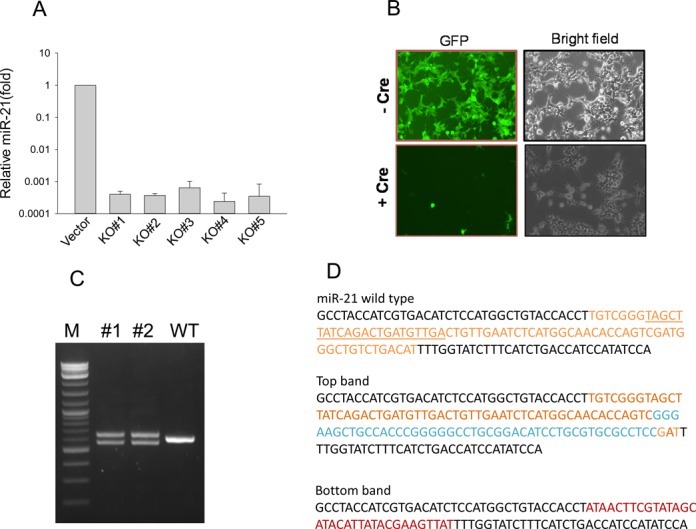
Identification of miR-21 KO clones and elimination of marker genes. (A) Detection of miR-21 level by qRT-PCR. Over a 1000-fold reduction was detected in all of the five miR-21 KO clones with P value <0.01 for all five clones. (B) Excision of marker genes in miR-21 KO clone #1 cells by Cre. Shown here are representative images. (C) Both miR-21 KO clones #1 and #2 carry distinct PCR products using primers miR-21–5.1 and miR-21–3.1. (D) DNA sequences for each of the PCR products from clones #1 and #2. Both clones revealed identical sequences. Insertion sequences are shown in blue and loxP sequences are in red.